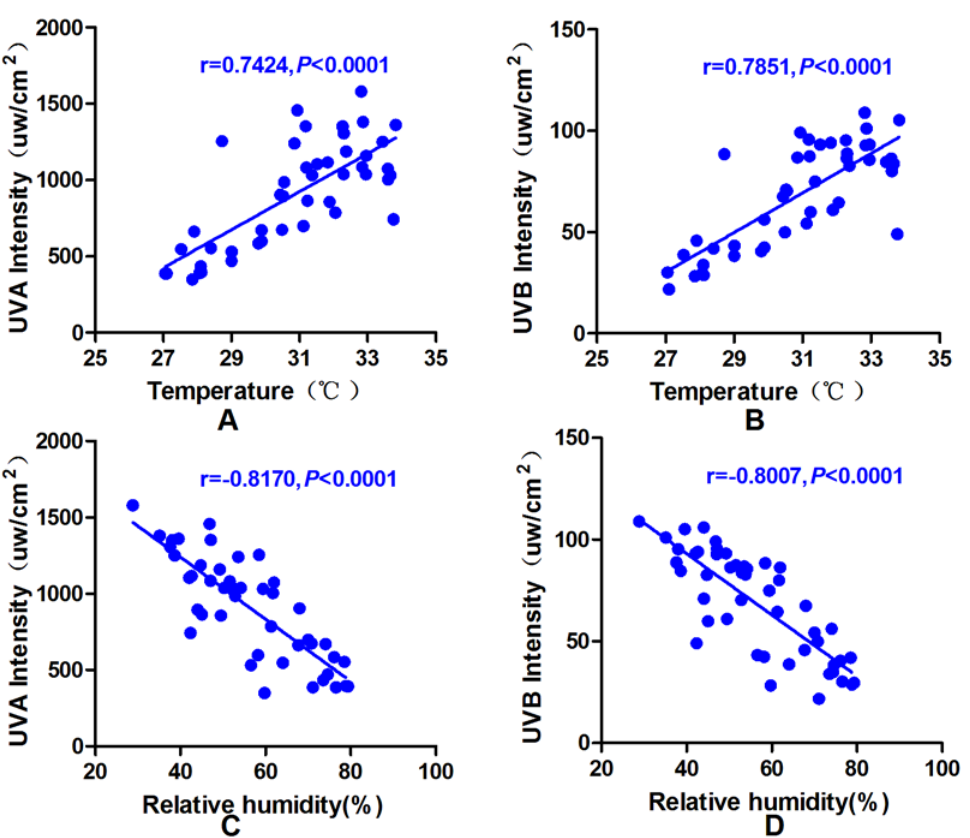
Fig 4. The relationship between ultraviolet intensity and humidity and temperature. A/B: Pearson ’ s correlation analysis revealed a significant positive correlation between temperature and UVA/UVB intensity (UVA: r = 0.7424, P < 0.0001; UVB: r = 0.7851, P < 0.0001). C/D: Pearson ’ s correlation analysis showed a significant negative correlation between relative humidity and UVA/UVB intensity (UVA: r = -0.8170, P < 0.0001; UVB: r = -0.8007, P < 0.0001).